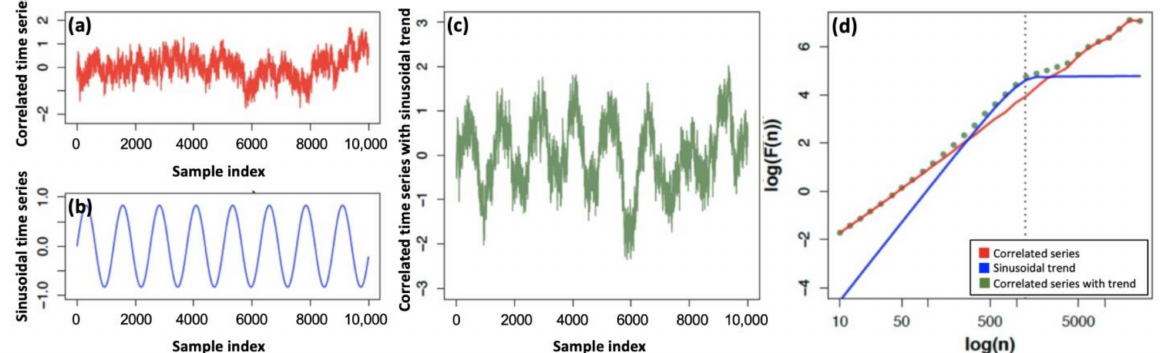
Figure 3. Crossover phenomenon in correlated time series: ( a ) correlated time series (scaling exponent ( α ) = 1.2); ( b ) sinusoidal trend (time period ( T ) = 1256); ( c ) the correlated time series with a sinusoidal trend; ( d ) the fluctuation function of the correlated series with a sinusoidal trend.